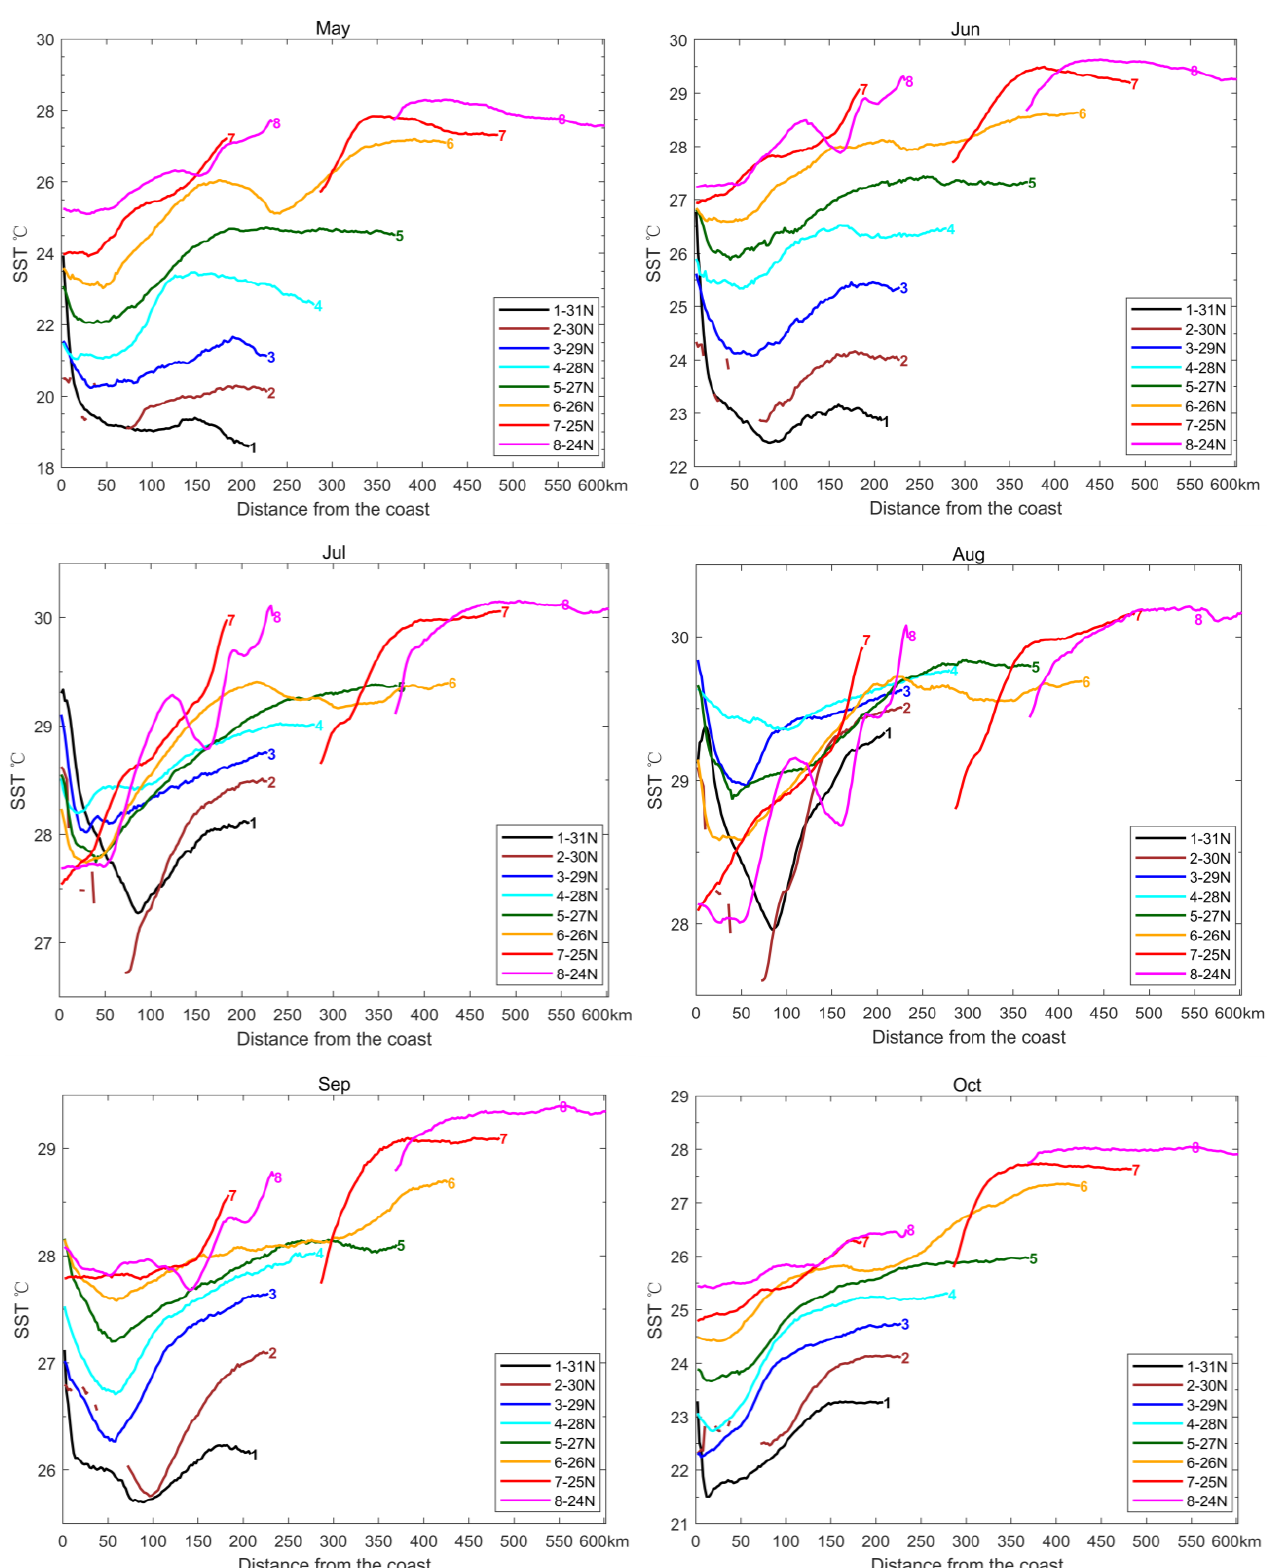
Figure 9. Long-term (2015 – 2020) mean monthly distributions of SST along the 8 zonal lines (Figure 7) across the CCF during summer months (May through October). The SST curve numbers in plot legends correspond to the zonal line numbers in Figure 7.